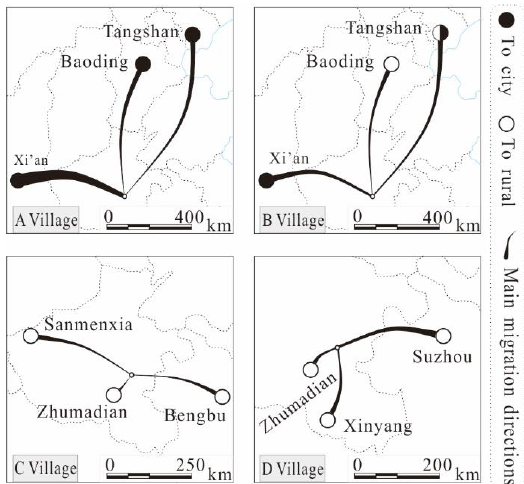
Figure 5. The main inflow places in each village.